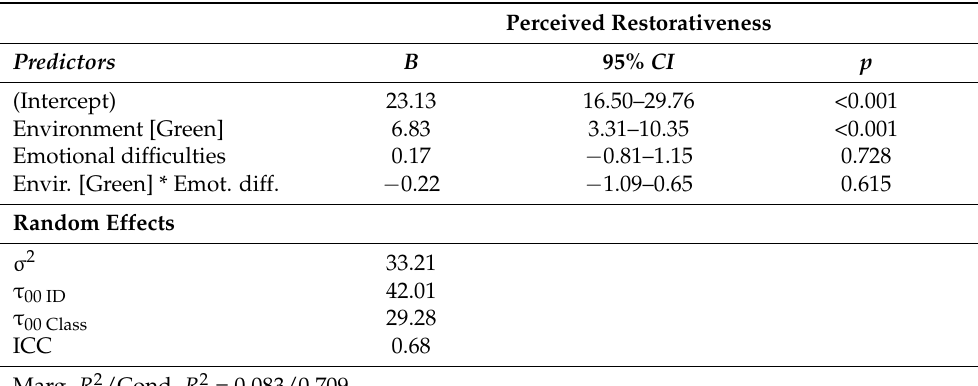
Table 5. Linear mixed for perception of environmental restorativeness.